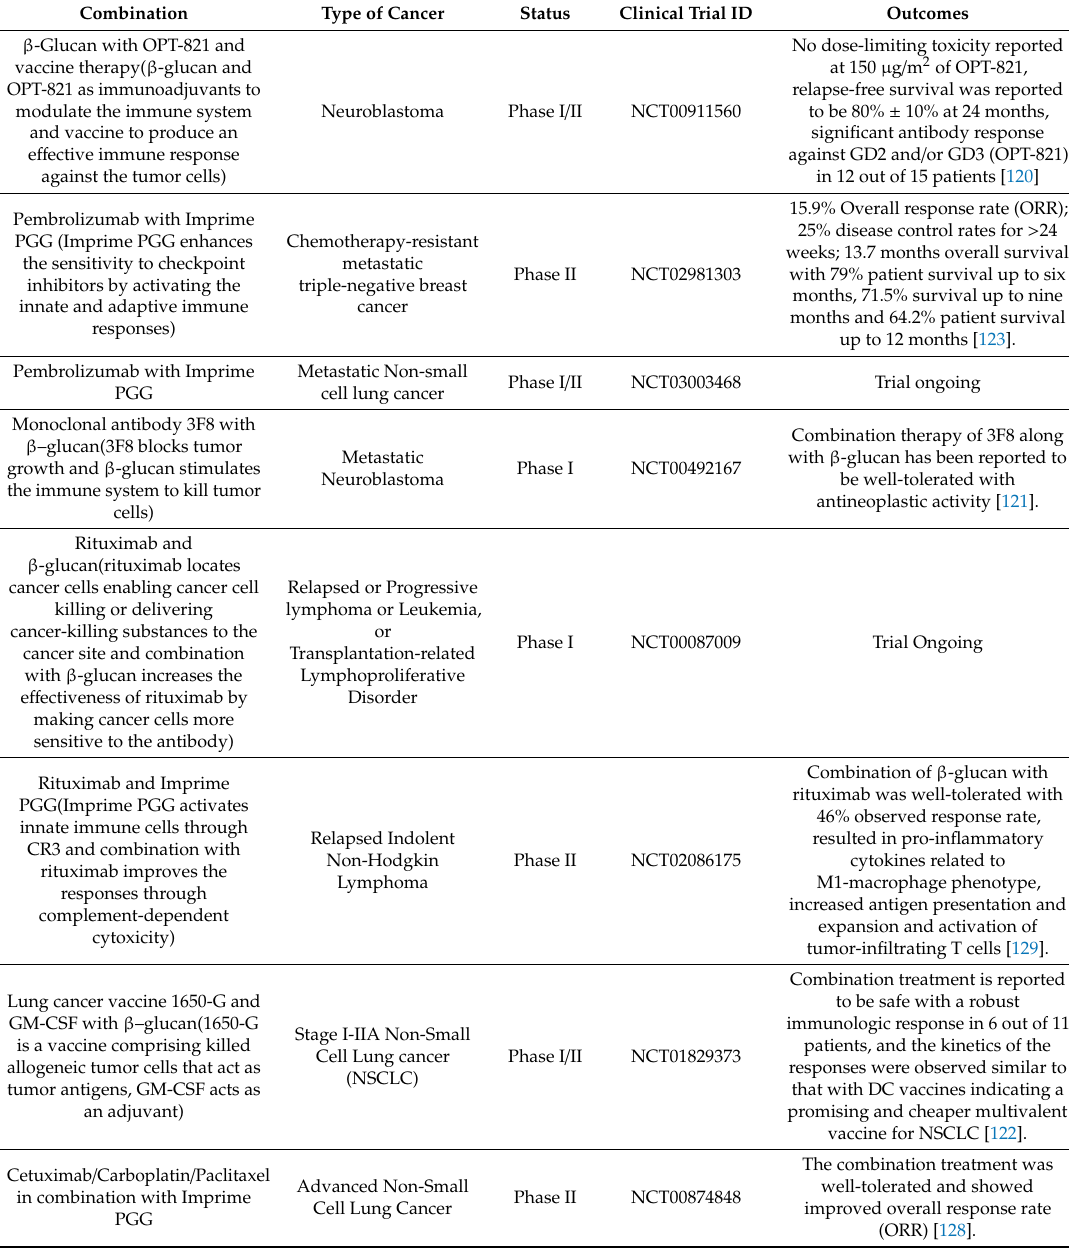
Table 2. Ongoing clinical trials using β -glucan in combination therapy for cancer treatment.